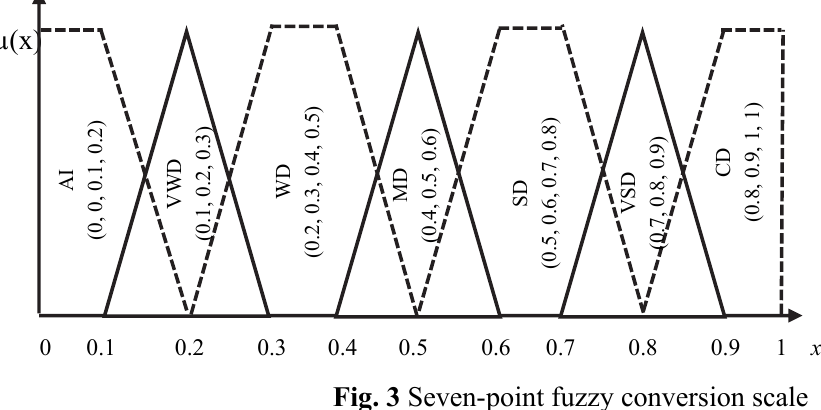
Fig. 3 Seven-point fuzzy conversion scale